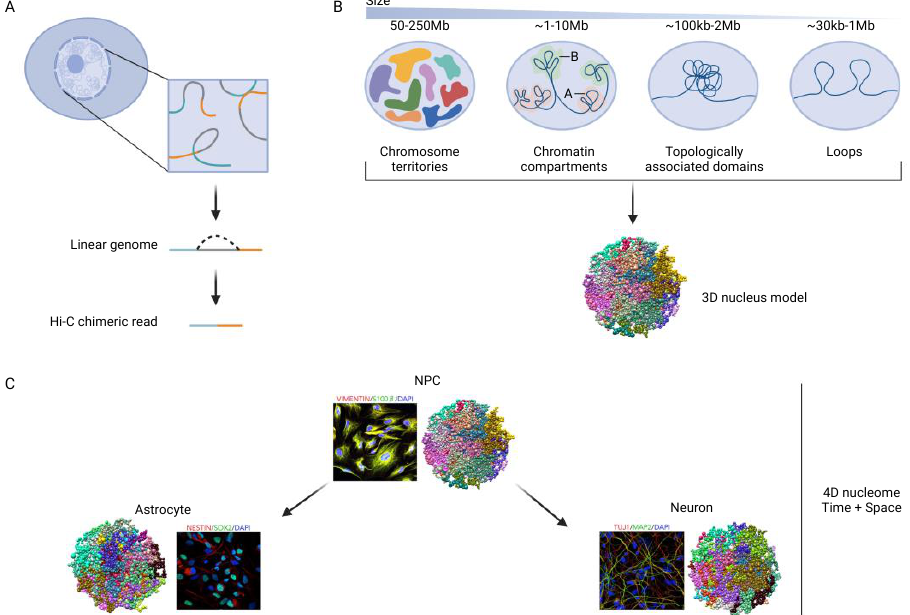
Figure 1. Hi-C Chromosomal contact (DNA-DNA proximity) mapping. ( A ) Basic principle. DNA- DNA proximity mappings typically use restriction digest followed by proximity religation techniques to capture chromosomal contacts. ( B ) basic building blocks of the 3D genome in the kilo- and megabase range. ( C ) chrom3D in silico model of topologically associated domains (TADs) [11,12], 1 ball = 1 TAD, TADs from same chromosome share the same color. The 4D nucleome is a concept for comprehensive, integrative analysis of the nucleus across time, including changes during differentiation.